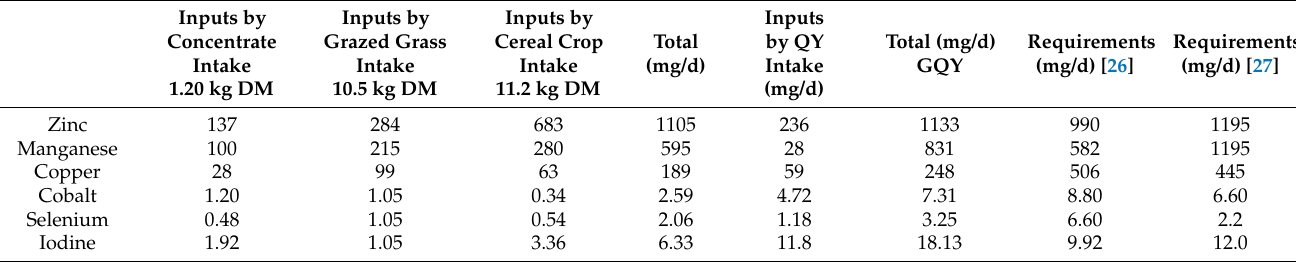
Table 5. Daily trace mineral inputs on average consumption of QY (mg/cow/d) and of concentrate (g/cow/d) compared to nutritional requirements edited by NRC (2001), updated in 2019 [26] and Meschy (2007) [27]. Inputs by Concentrate Intake 1.20 kg